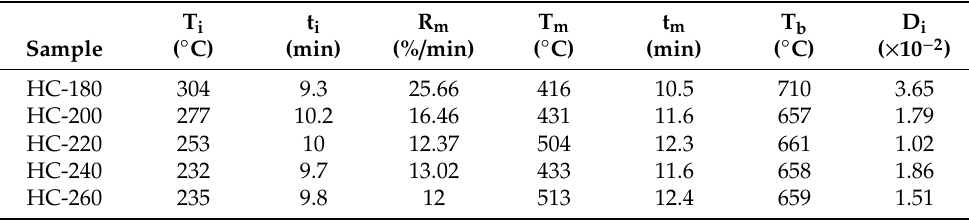
Table 5. Fuel properties of hydrochars prepared at various temperatures.